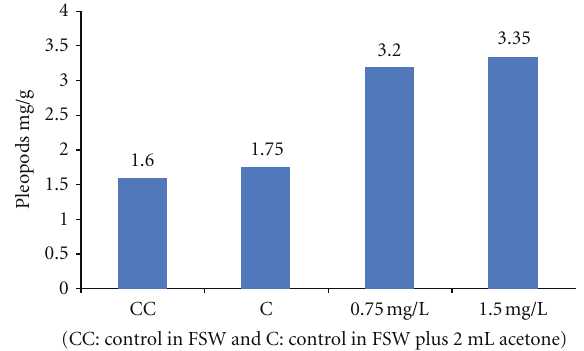
Figure 8: Mean DNA concentration of L. vannamei exposed to creosote for 21